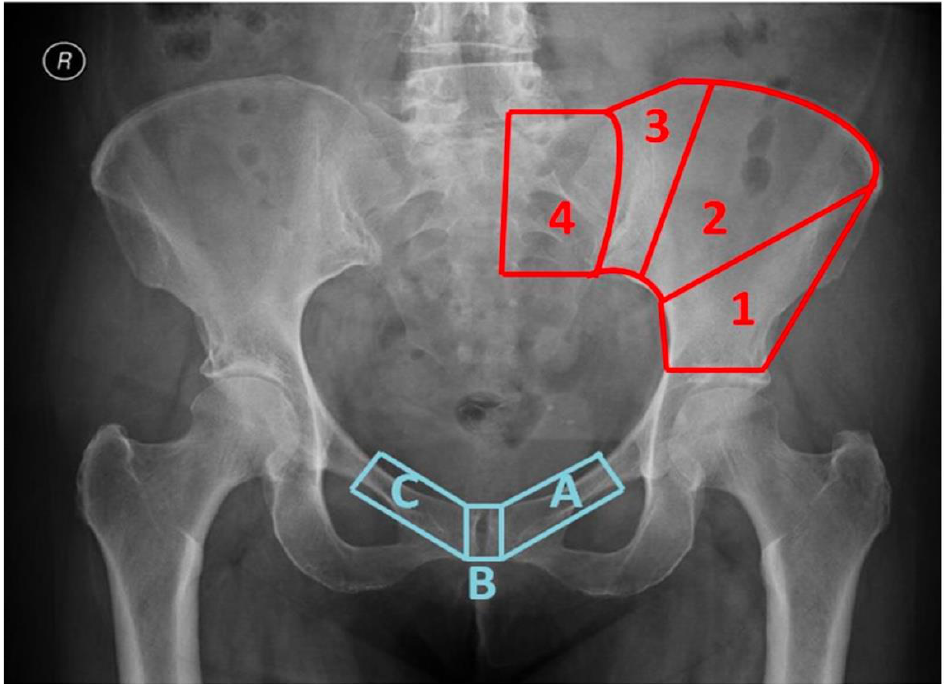
Figure 1. Classification system based on the amount of bone resected. Numbers are related to the four different regions in which the proximal osteotomy (super acetabular) can be made. Letters define the distal osteotomy (medial) location.